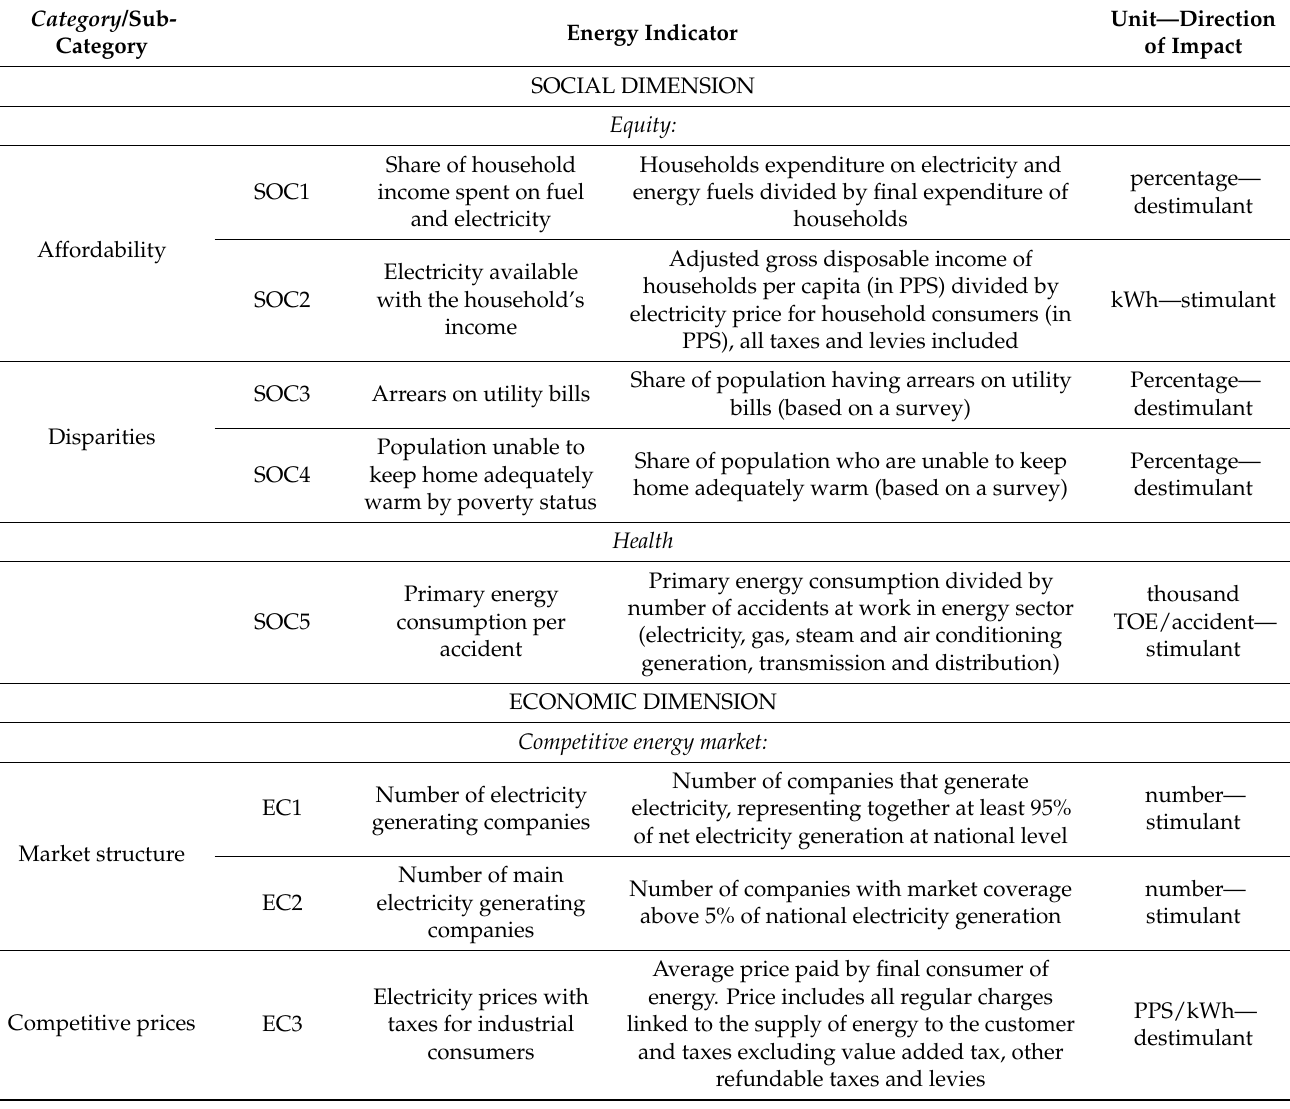
Table 1. Dimensions, categories, sub-categories and indicators of sustainable